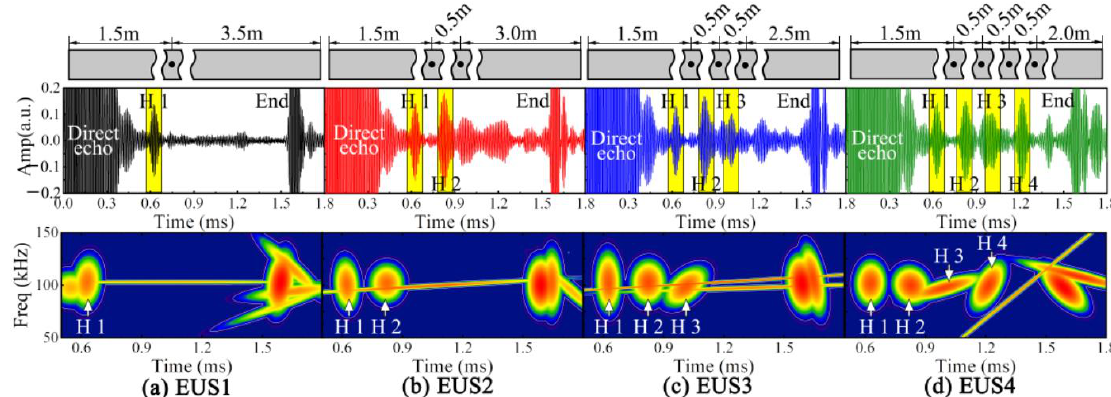
Figure 14. Experimental UGW signals: ( a ) EUS 1, ( b ) EUS 2, ( c ) EUS 3, and ( d ) EUS 4.